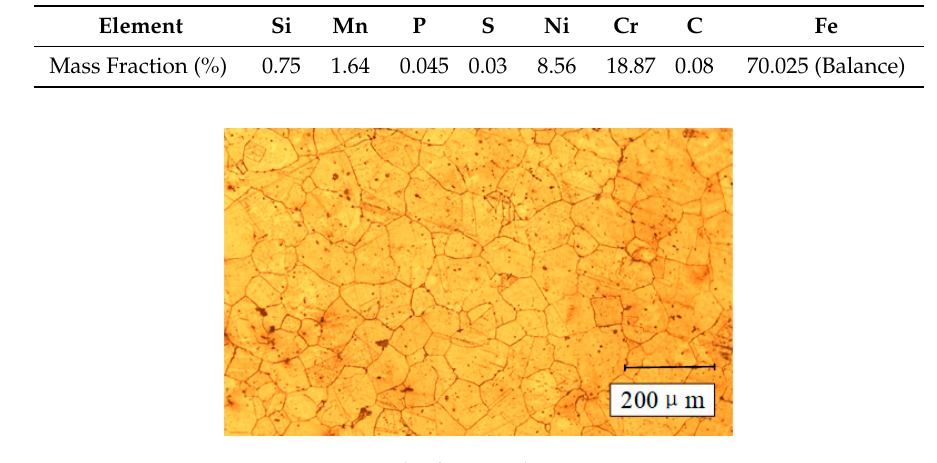
Figure 2. Micrograph of material matrix microstructure.